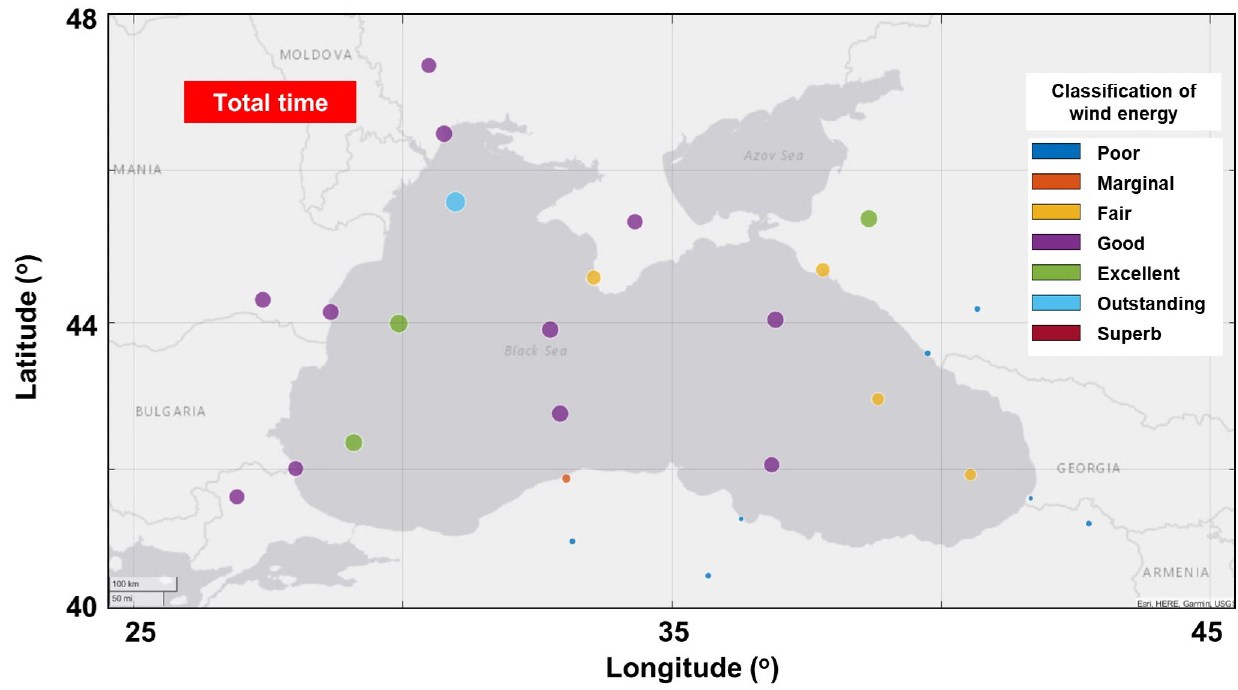
Figure 9. Wind energy classification involving eight parameters ( Wann , EWSO , RLO , C V , M v , EWS , WD , DC ) corresponding to the total time distribution (2002–2021). These results consider the U 100 parameter and are based on the methodology proposed in Costoya et al. [17].